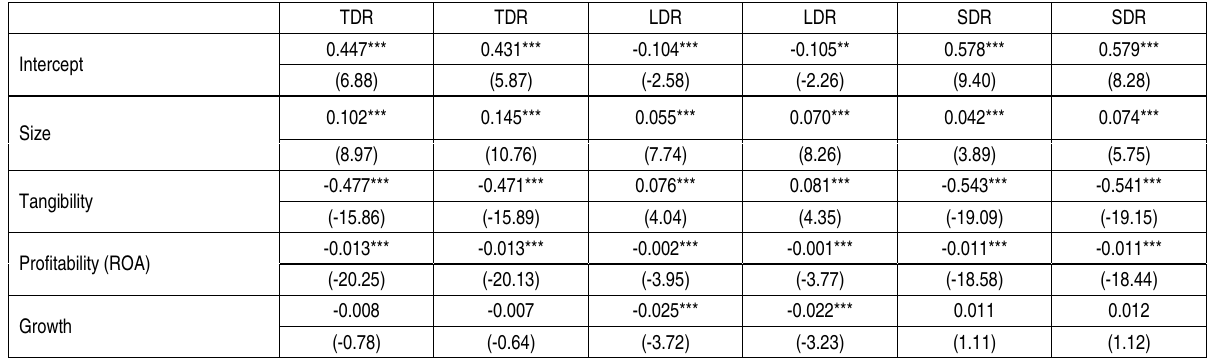
Table 1. Panel regression